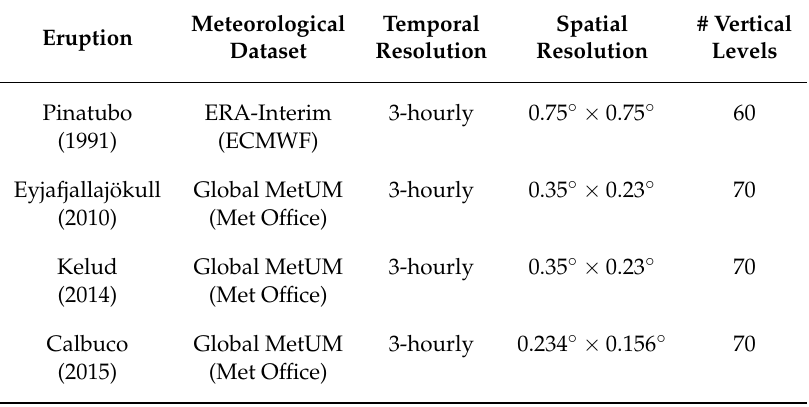
Table 2. The NWP meteorological fields used as input for the NAME simulations. Note the increase in spatial resolution of Global MetUM over